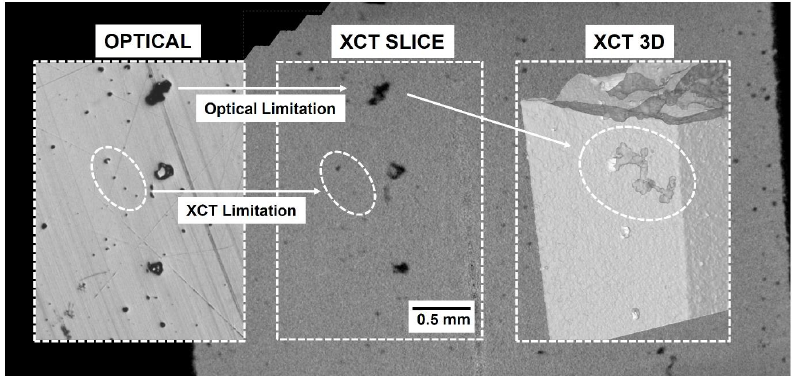
Figure 8. Comparison of pores measured using XCT and optical microscope.